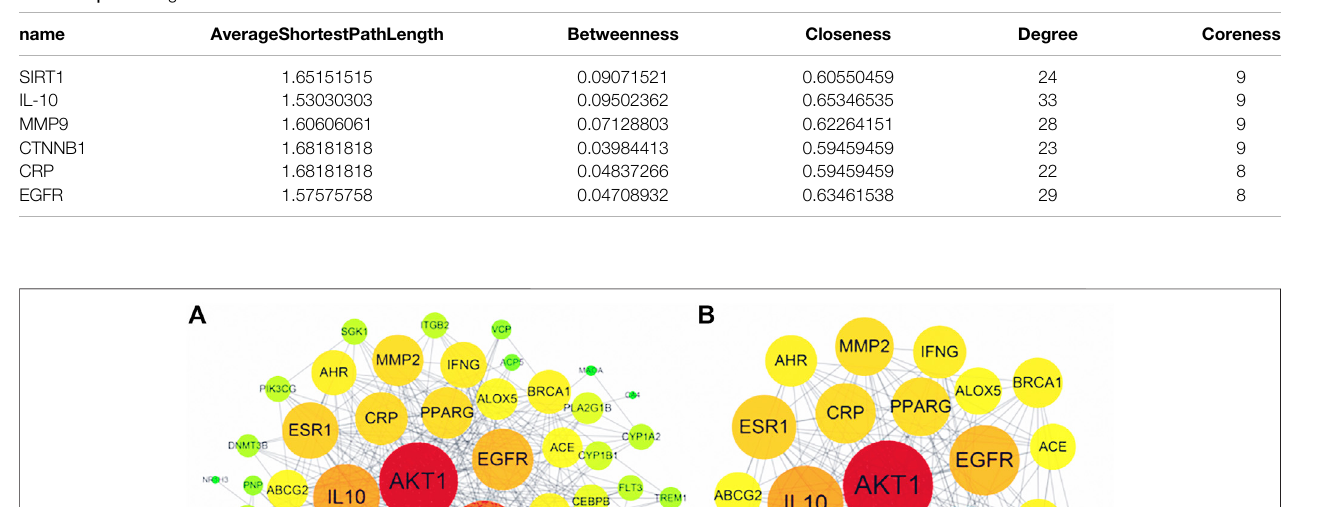
Frontiers in Pharmacology |